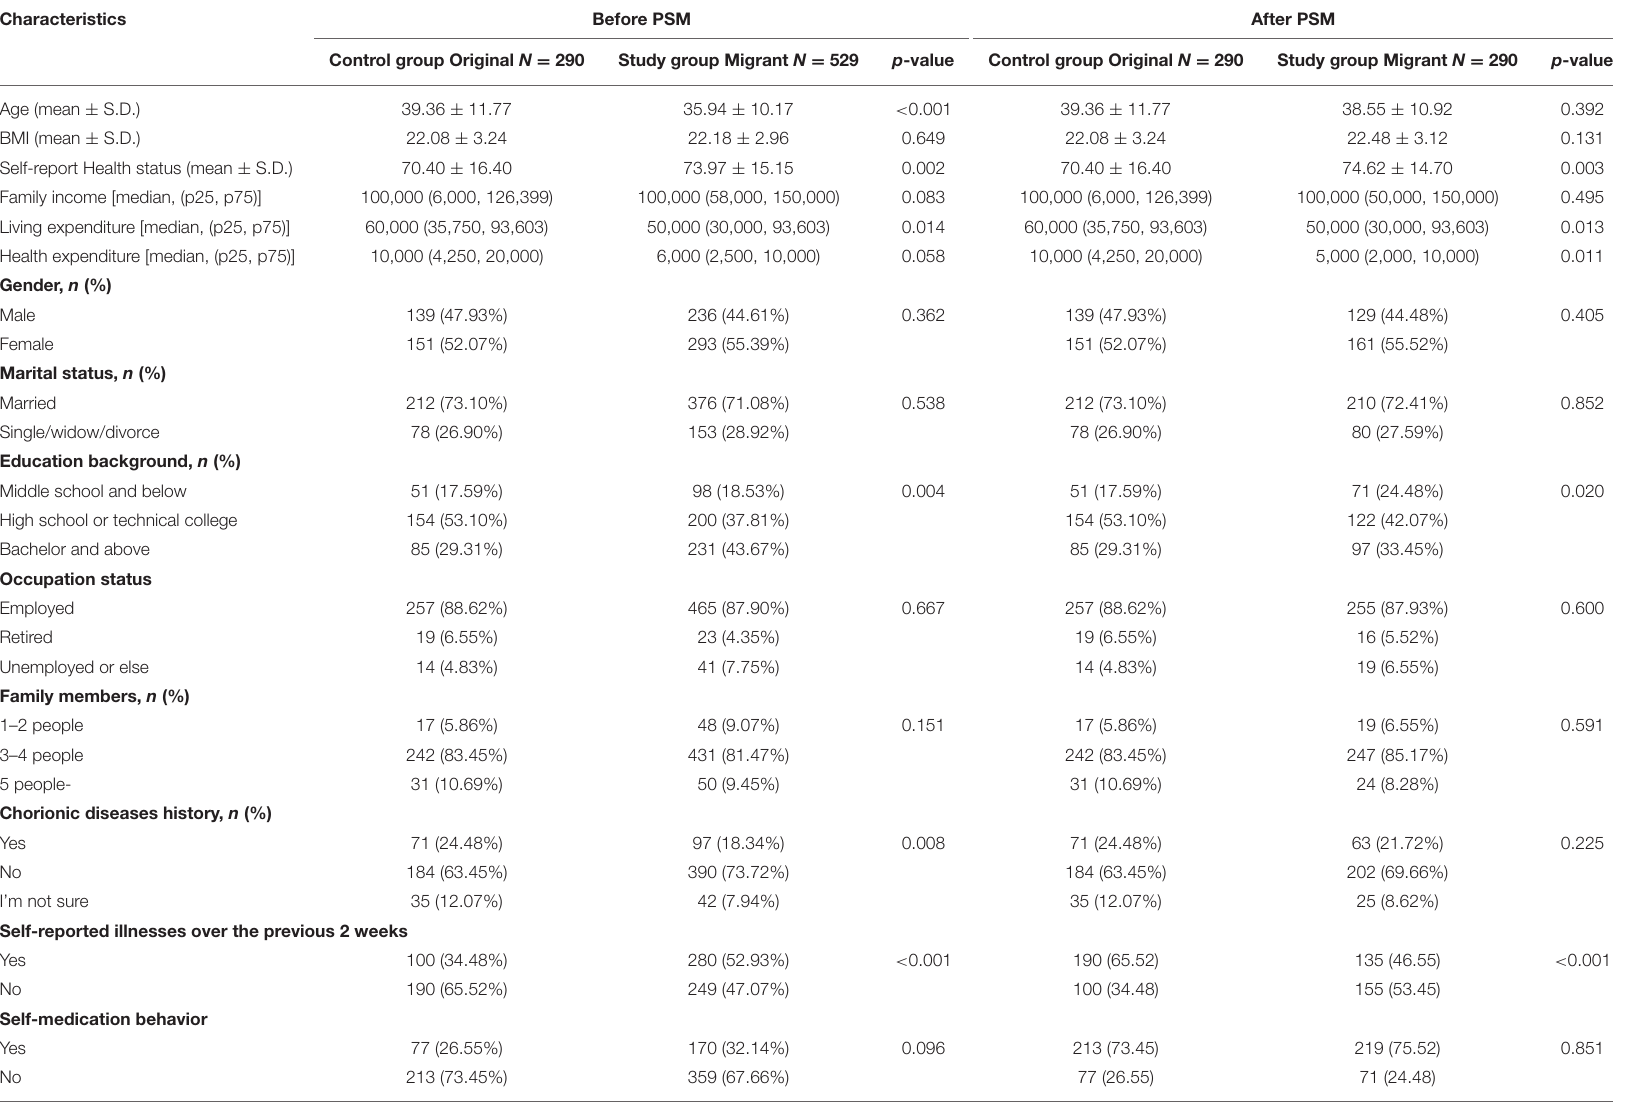
TABLE 1 | Demography characteristics of migrant group compared to aboriginal group before and after propensity score matching (PSM). Characteristics Before PSM After